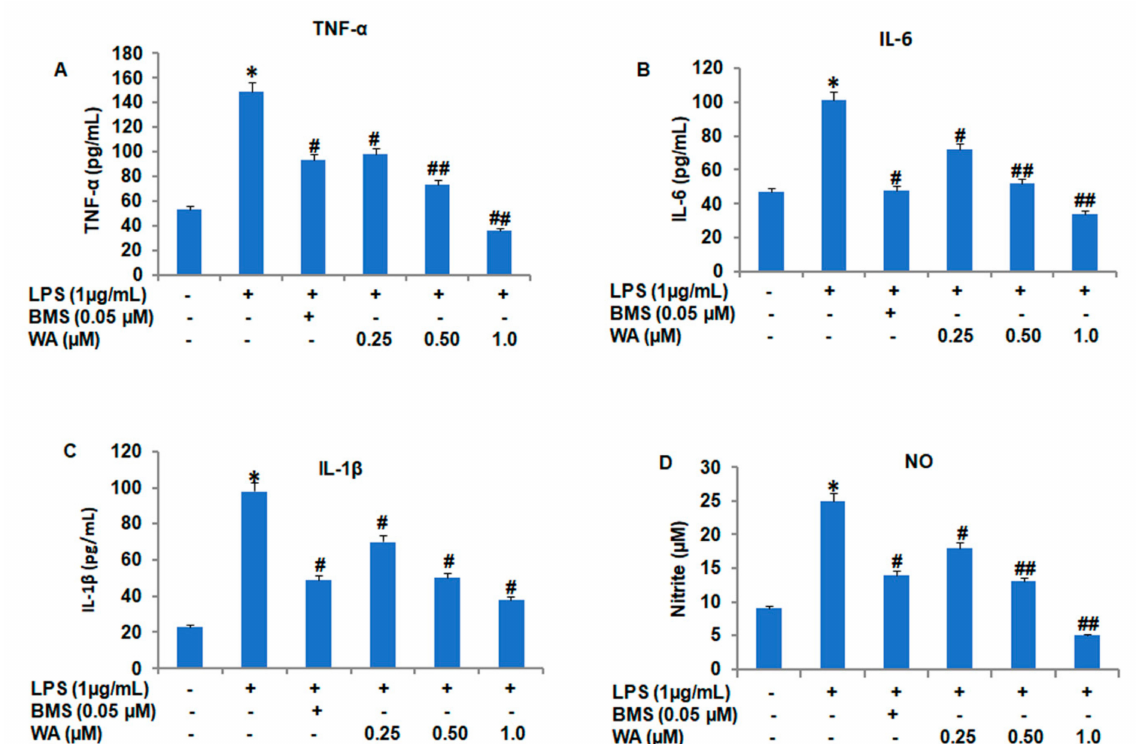
Figure 3. WA inhibits pro-inflammatory cytokines secreted by macrophages isolated from the peritoneal cavity of BALB/c mice. ( A – D ) The histogram represents the level of TNF- α (pg/mL), IL-6 (pg/mL), IL-1 β (pg/mL), and NO ( µ g/mL) in conditioned media obtained from cultured macrophages after LPS stimulation, followed by exposure to different doses (0.25, 0.5, and 1.0 µ M) of WA, along with BMS (0.05 µ M) and LPS stimulation alone and untreated control group, after 48 h. Experimental data are presented as the mean ± SEM from three or more independent experiments. * p ≤ 0.05 (comparison vs. LPS only) and # p ≤ 0.05, and ## p ≤ 0.01 (comparison vs. +LPS)